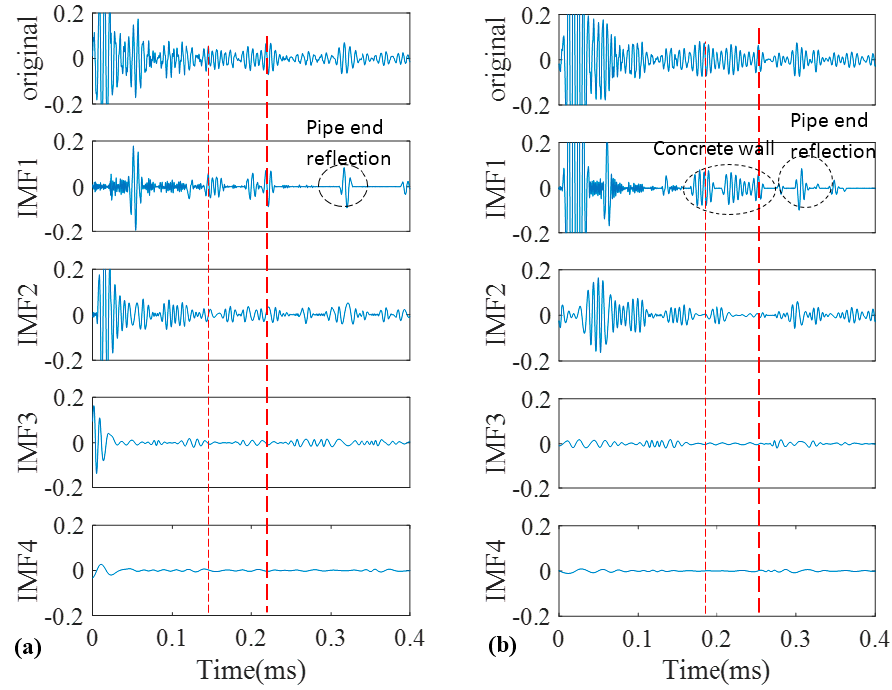
Figure 11. Decomposition of signals into their IMFs by EMD for the pristine pipe ( a ); and the pipe with a natural corrosion ( b ).